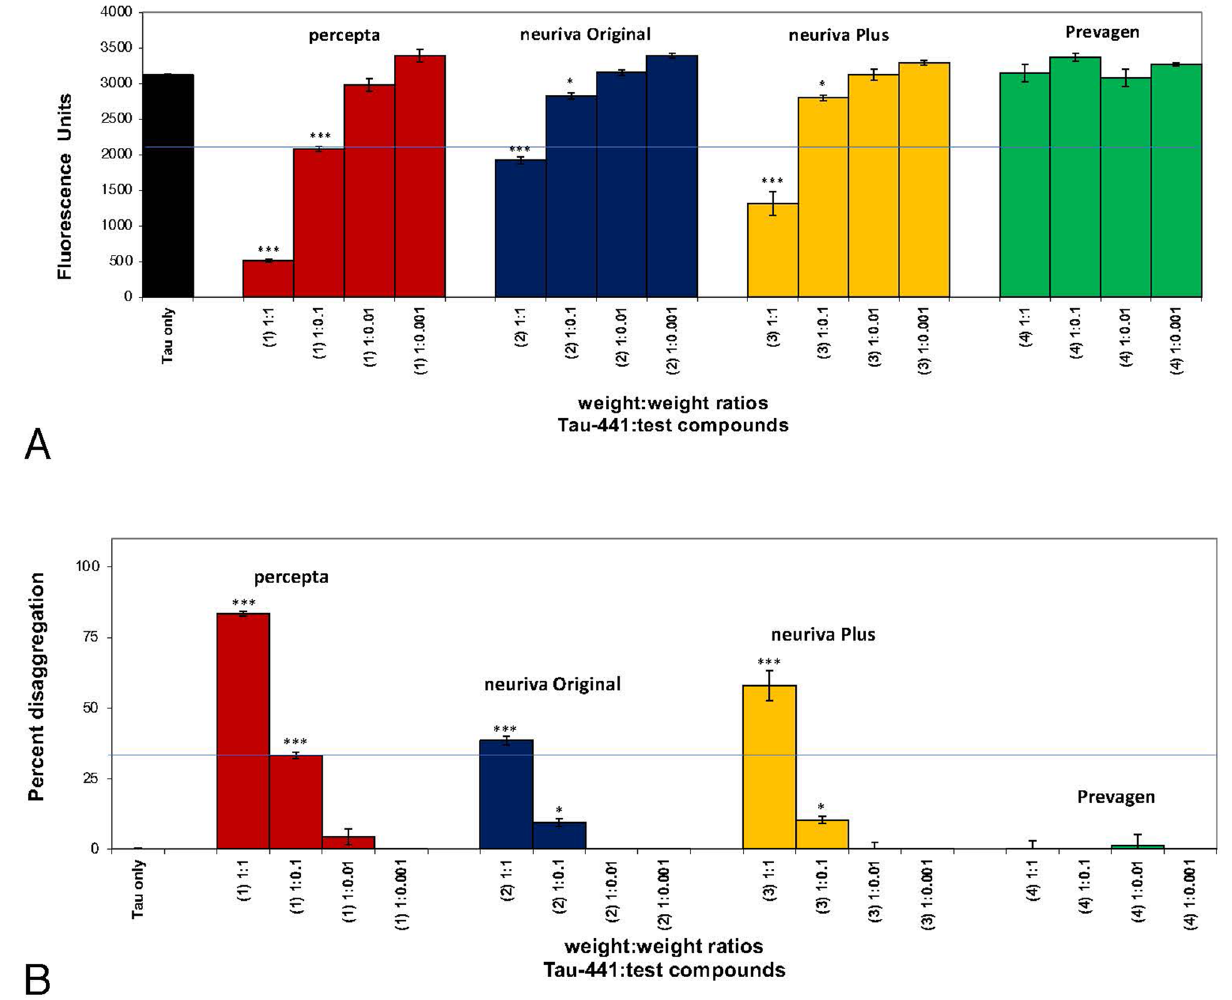
Figure 7. Percepta outperformed neuriva (Schiff Vitamins) for disaggregation /disruption of pre-formed tau tangles. ( A ) Percepta was tested in direct comparison to neuriva (neuriva Original and neuriva Plus) and Prevagen memory-support supplements on a wt/wt basis. Percepta was the most potent disrupter of tau tangles in comparison to neuriva (neuriva Original and neuriva Plus) and Prevagen on a wt/wt basis as determined quantitatively by Thioflavin T fluorometry. Tau protein tangles fibrils demonstrated binding to Thioflavin T and 3,120 fluorescence units. Percepta demonstrated the most robust disaggregation/dissolution of pre-formed tau tangles in a dose-dependent manner. *p < 0.05, **p < 0.01, ***p < 0.001, by Student’s t-test. Bars represent mean ± SEM. ( B ) Comparison (on a wt/wt basis) of percepta to neuriva (Original and Plus) and Prevagen for % disaggregation of pre-formed tau tangles at 4 increasing dosages. Percepta had the most robust activity and reduced/disaggregated tau tangles in a dose-dependent manner (light brown bars). At a tau:percepta wt:wt ratio of 1:0.1 (blue line across graph), percepta disaggregated tau tangles by 33.5%, whereas neuriva Original at that dose only disaggregated tau tangles by 8.1%, neuriva Plus only disaggregated tau tangles by 10.4%, and Prevagen did not work on reducing tau tangles at all. At a 1:1 wt/wt dose percepta reduced tau tangles by 85.7%, whereas neuriva Original and neuriva Plus only reduced tau tangles by 38.4% and 57.4%, respectively, whereas Prevagen had no effects at all. *p < 0.05, **p < 0.01, ***p < 0.001, by Student’s t-test. Bars represent mean ±